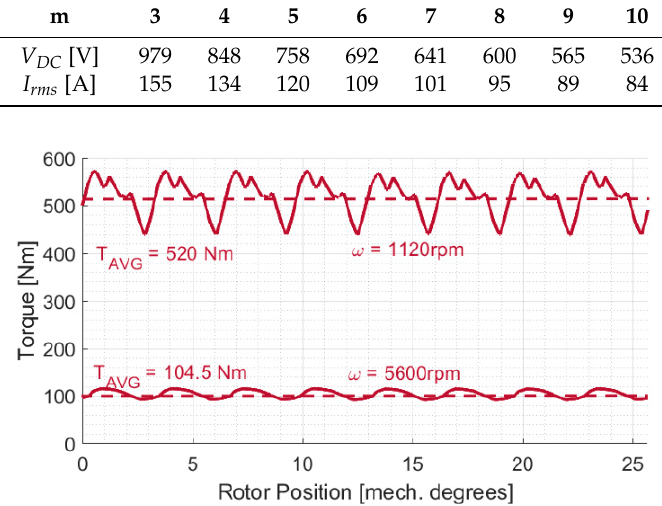
Figure 7. Torque vs. rotor positions loci at both base and maximum speed.